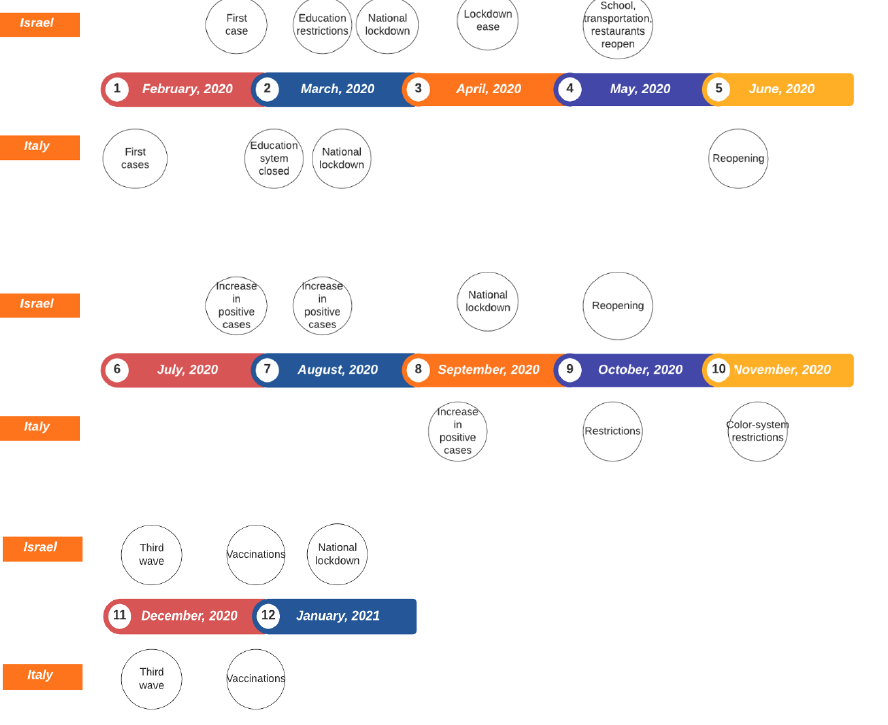
Figure 12. Main pandemic events in Italy and Israel.